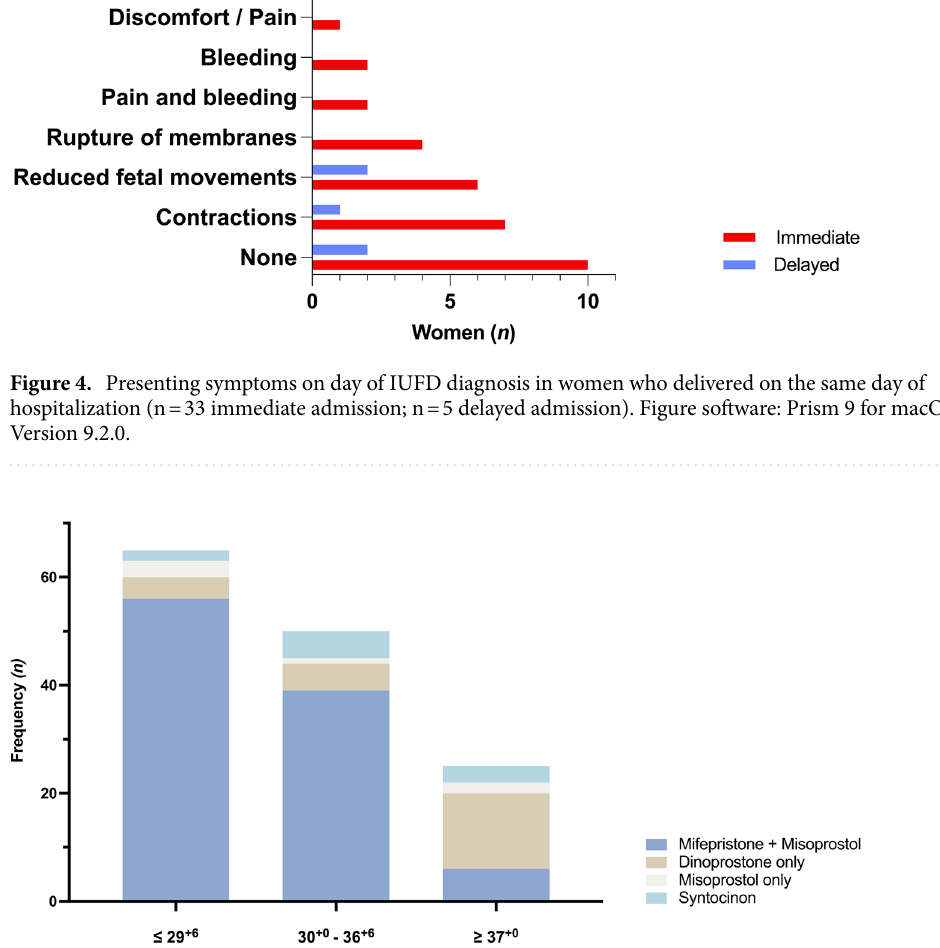
Figure 5. Methods of induction of labor following fetal death at the Department of Obstetrics and Gynecology, Medical University of Vienna, Austria, between 2003 and 2019 (“ Dinoprostone only” includes Propess, Prostin E2; “Misoprostol only” includes Cytotec, Misodel, Cyprostol). Figure software: Prism 9 for macOS, Version